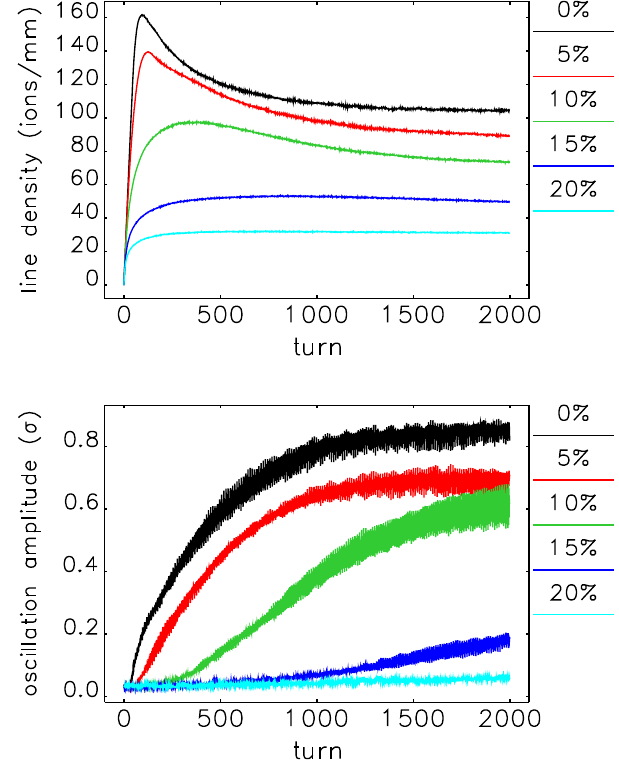
FIG. 7. Ion density (top) and instability amplitude (bottom), comparing simulations with increasing bunch charge